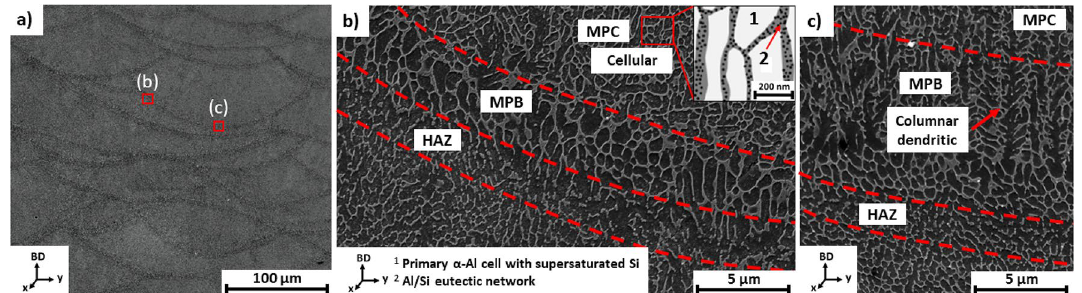
Figure 4. SEM images showing ( a ) the AB mesostructure presenting the overlapping meltpools in conduction mode; ( b ) and ( c ) magnified SEM images at the meltpool boundary showing the morphological transition of the microstructure between the meltpool centre (MPC—cellular), meltpool boundary (MPB—columnar dendritic), and heat-affected zone of the meso- and micro-scaled structural features were manually quantified using the ImageJ software and a scale calibration based on the pixel aspect ratio of the image. The meltpools have an average meltpool width of 189 ± 15 µm and meltpool depth of 114 ± 8 µm. The meso-scale meltpools are visible because of the distinct morphological transition of the microstructure between the meltpool centre (MPC), meltpool boundary (MPB), and the heat-affected-zone (HAZ), as noticeable in Fig. 4b,c. The MPC’s microstructure consists of a primary α-Al matrix exhibiting an ultrafine cellular morphology with an average cell size of 0.46 ± 0.09 µm and a Si-rich eutectic network in the intercellular region, as a secondary phase. The MPB exhibits a coarser microstructure of α-Al cells (0.89 ± 0.24 µm) mixed with columnar dendrites and with the Si-rich eutectic network surrounding these cells and dendrites. The HAZ shows a partial disintegration and spheroidisation of the Si eutectic network. Figure 5a,d,g show the evolution of the mesostructure for the respective conditions (AB, DA, and SR). AB and DA show no significant difference for the mesostructure. On the other hand, the mesostructure homogenises partially after SR, yet the meltpool boundaries are still noticeable in certain regions. Microstructure. The microstructural evolution of the AB, DA, and SR conditions was evaluated based on the microstructural images and Si STEM-EDX mappings, taken from the bulk of the material and displayed in Fig. 5. The AB microstructure shows sub-micrometre-sized primary α-Al cells surrounded by the Al/Si eutectic network in the intercellular region, shown in Fig. 5a–c. After DA, ultrafine needle-like and cubic-like Si precipi- tates form in the primary Al cell while the eutectic network remains intact, as indicated in Fig. 5d–f. After SR, the microstructure evolves through the disintegration of the Al/Si eutectic network, followed by spheroidisation, thus obtaining coarse Si particles along the Al cell boundaries. Likewise, Si particles precipitate from the primary Al cell. The SR microstructure exhibits coarser Si particles with a less dense particle distribution when compared